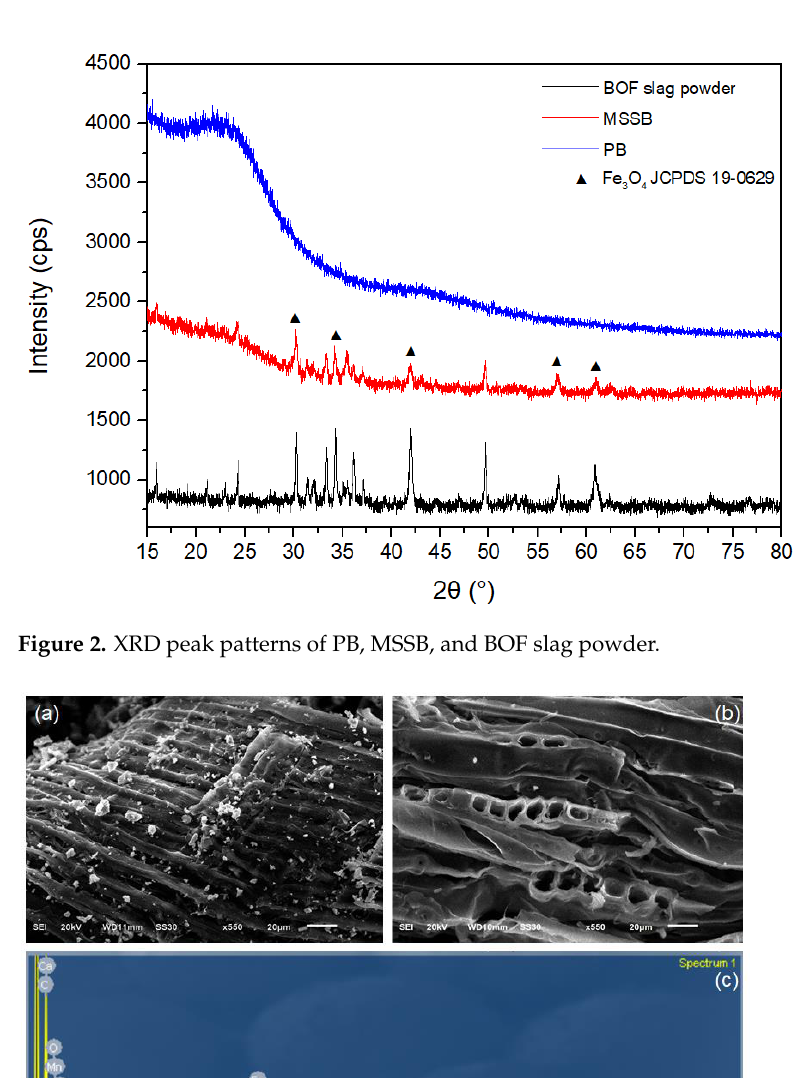
Figure 2. XRD peak patterns of PB, MSSB, and BOF slag powder.